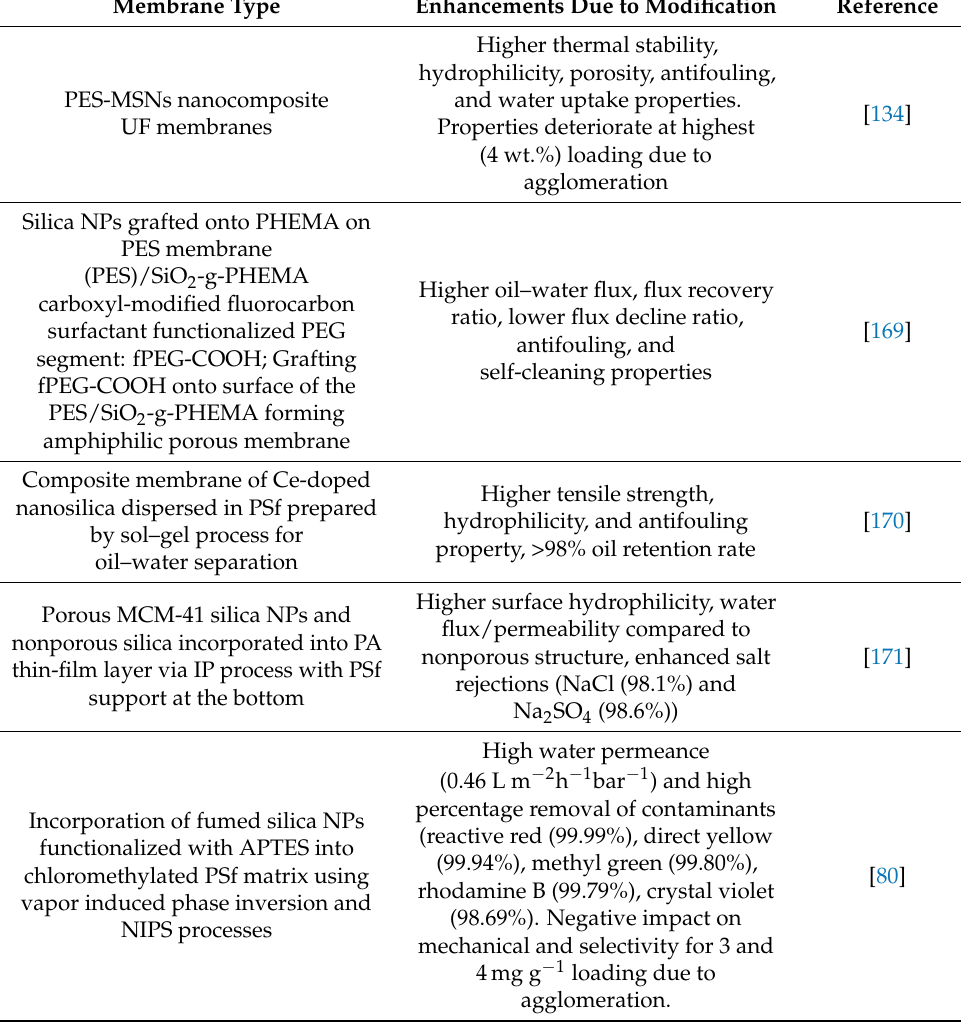
Table 2. Cont. Membrane